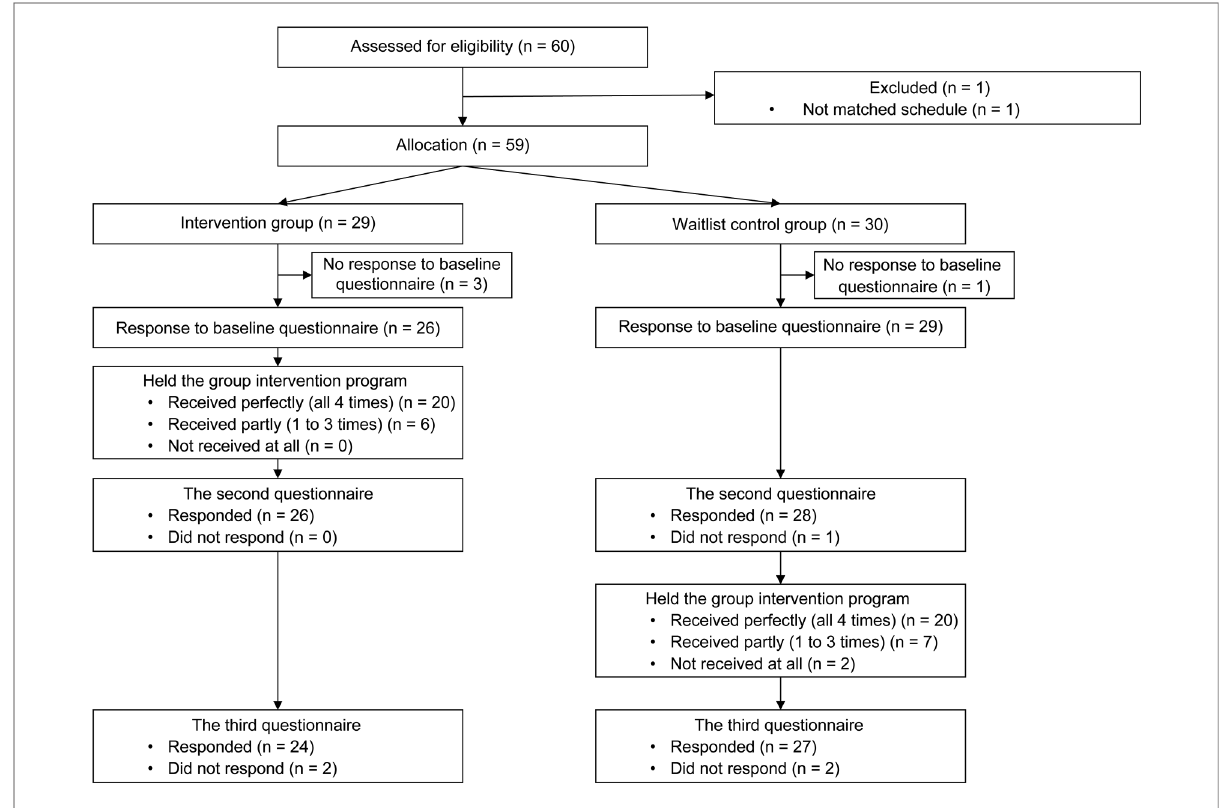
FIGURE 1 Participant fl ow